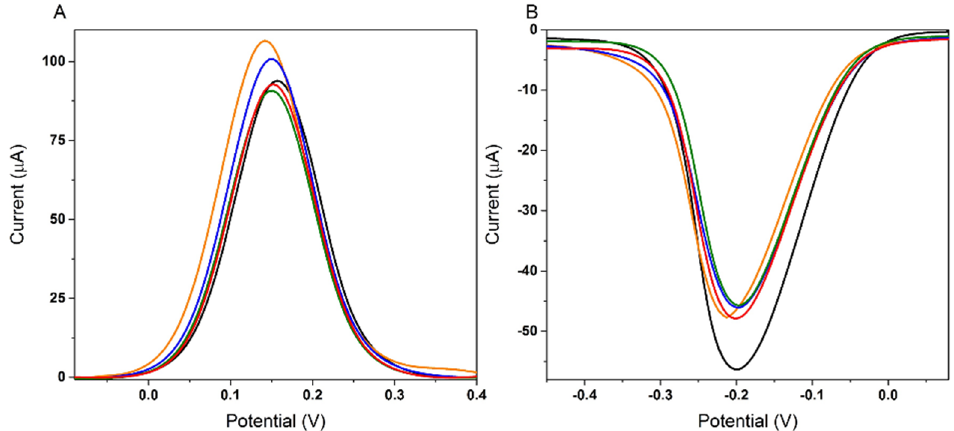
Figure 5. Electrochemical DPV characterization of the electrode surface after each modification step using the following as a redox probe: 1 mM FcDM in 0.1 M KCl ( A ); 5 mM Ru(NH 3 ) 6 Cl 3 in 0.1 M KCl ( B ) on bare electrode ( black ); C-SPE/AuNPs ( orange ); C-SPE/AuNPs/APT ( blue ); C-SPE/AuNPs/APT/MCH ( green ); and after incubation with 1 µ M 3-O-C 12 -HSL ( red